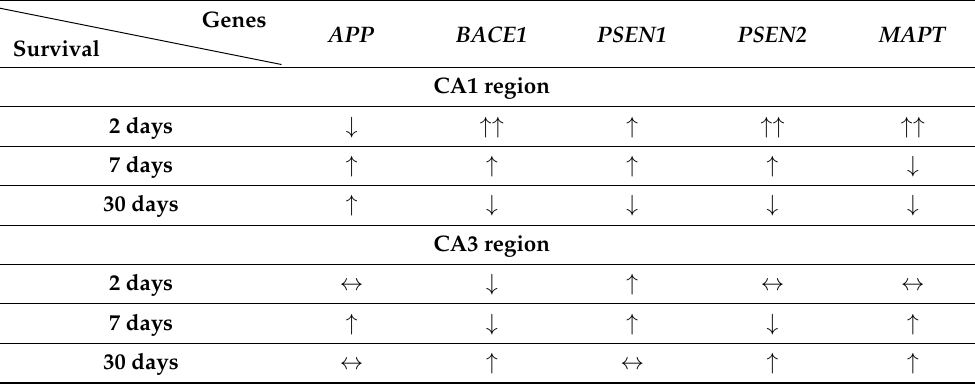
Table 1. Changes in the expression of amyloid protein precursor (APP), β -secretase (BACE1), presenilin 1 (PSEN1), presenilin 2 (PSEN2), and tau protein (MAPT) genes in the CA1 and CA3 areas of the hippocampus at different times after brain ischemia. Genes APP BACE1 PSEN1 PSEN2 MAPT Survival CA1